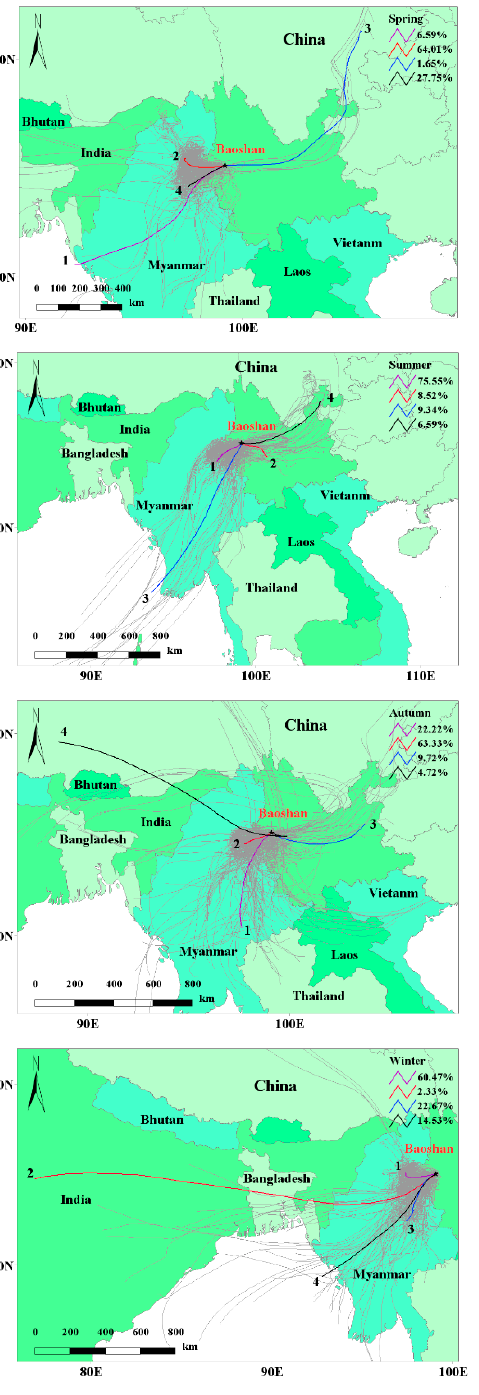
Figure 12. O 3 backward trajectory clustering and WPSCF analysis of four seasons in Baoshan city in